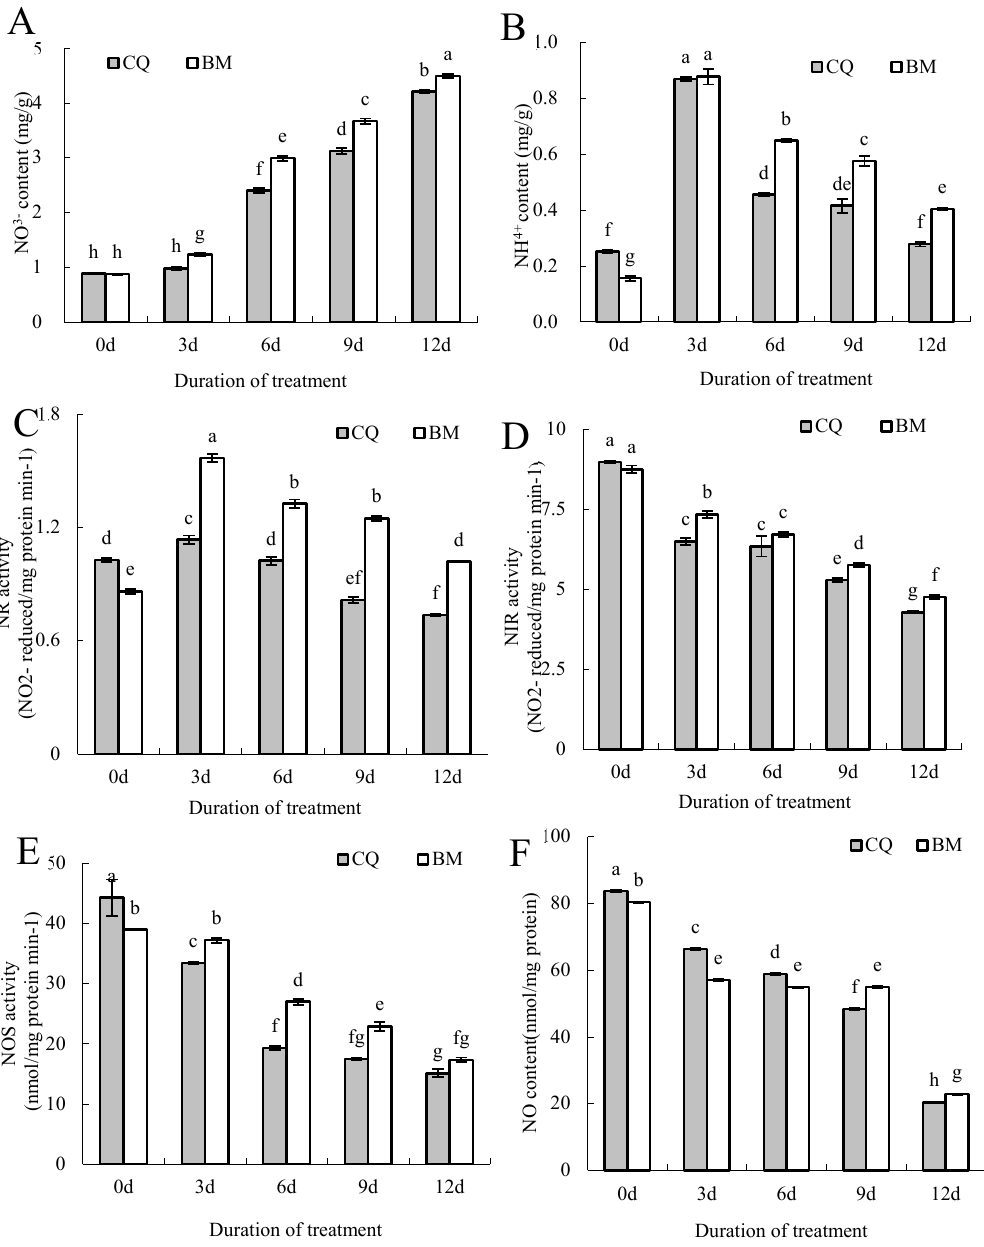
Figure 5. Determination of NO 3 − content ( A ), NH 4 + content ( B ), nitrite reductase ( C ), NIR activity ( D ), NOS activity ( E ), and NO content ( F ) in cucumber roots at 0, 3, 6, 9, and 12 days after Ca(NO 3 ) 2 treatment. Values are the means of three independent experiments. Bars marked with dissimilar letters are significantly different according to Duncan’s multiple range tests ( p < 0.05).